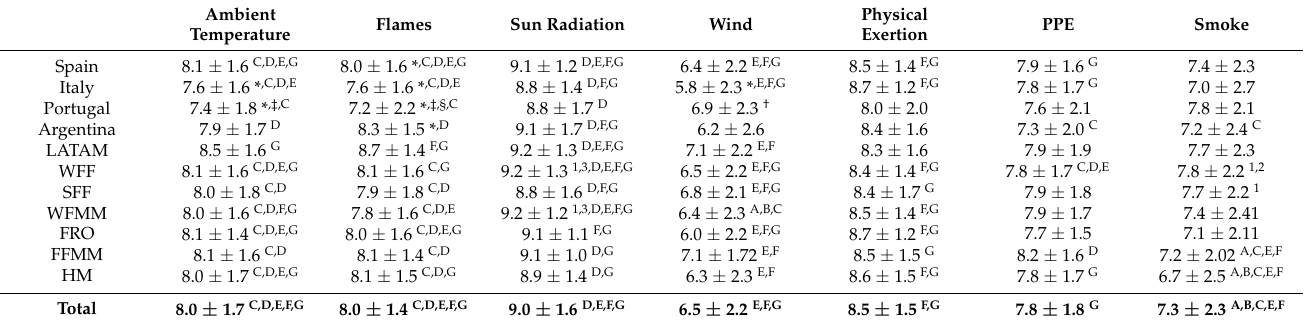
Table 3. Scores assigned to the different factors related to thermal stress during wildland fire suppression by country and job position (n = 1459). Values expressed as mean ± SD.